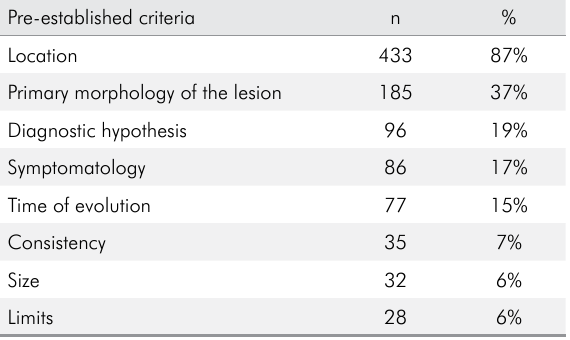
Table 5. Pre-established criteria in referral